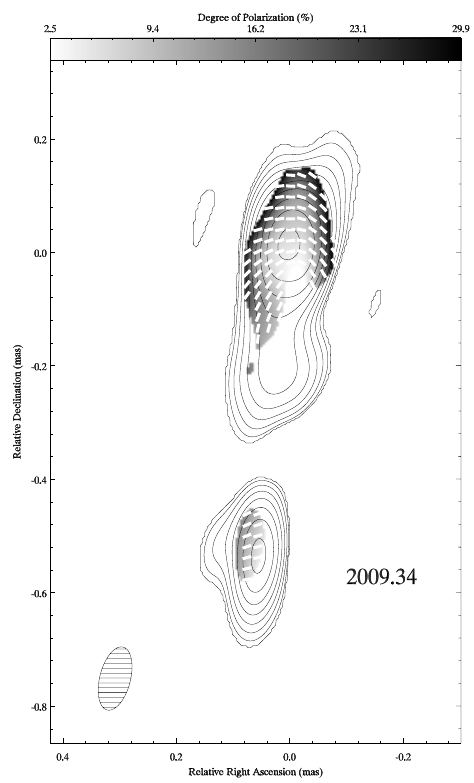
Figure 5. Linear polarization degree of NRAO 150 as measured at 86 GHz superposed with the distribution of the magnetic vector position angle during 2009.